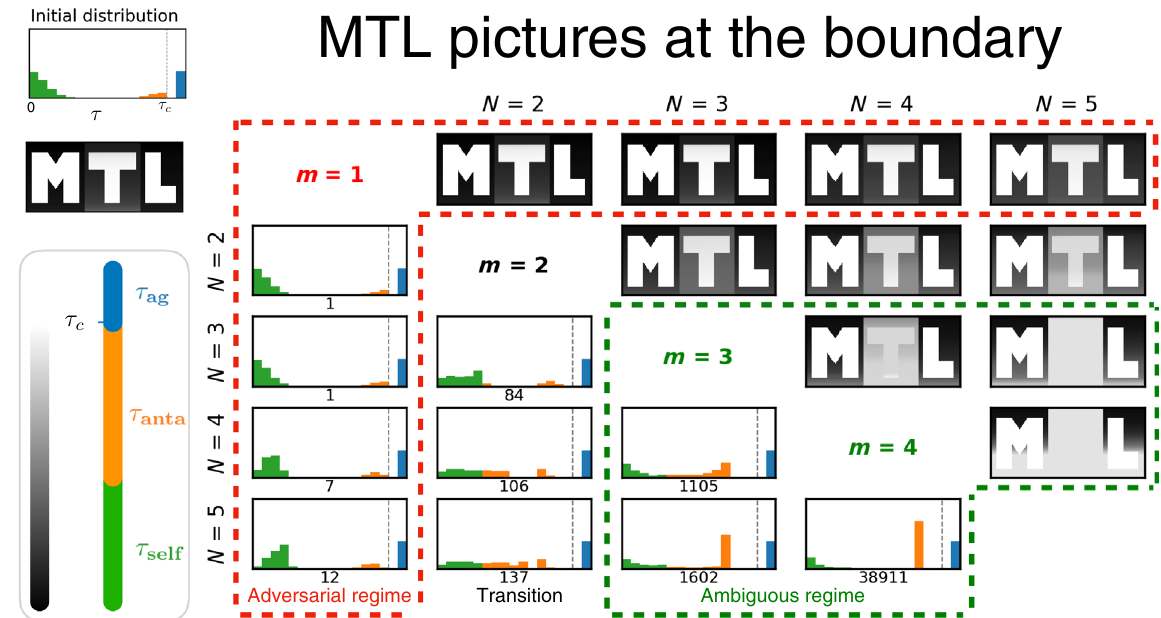
FIG. 5. MTL pictures. Explanation is found in the